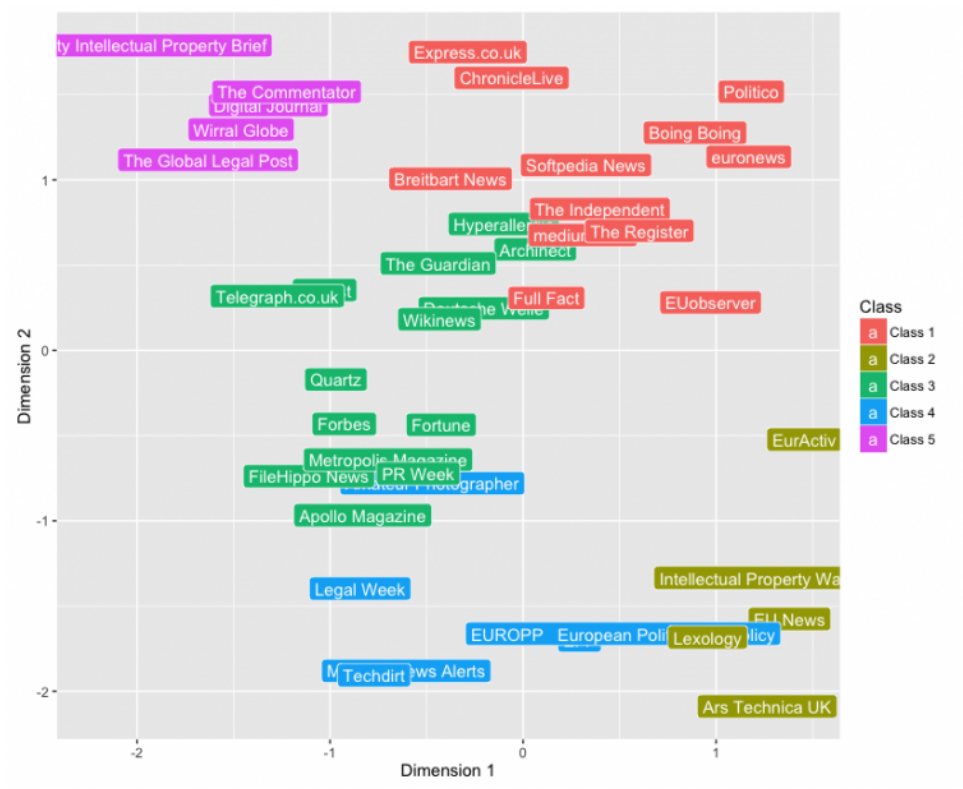
Figure 7: Cluster analysis in the English